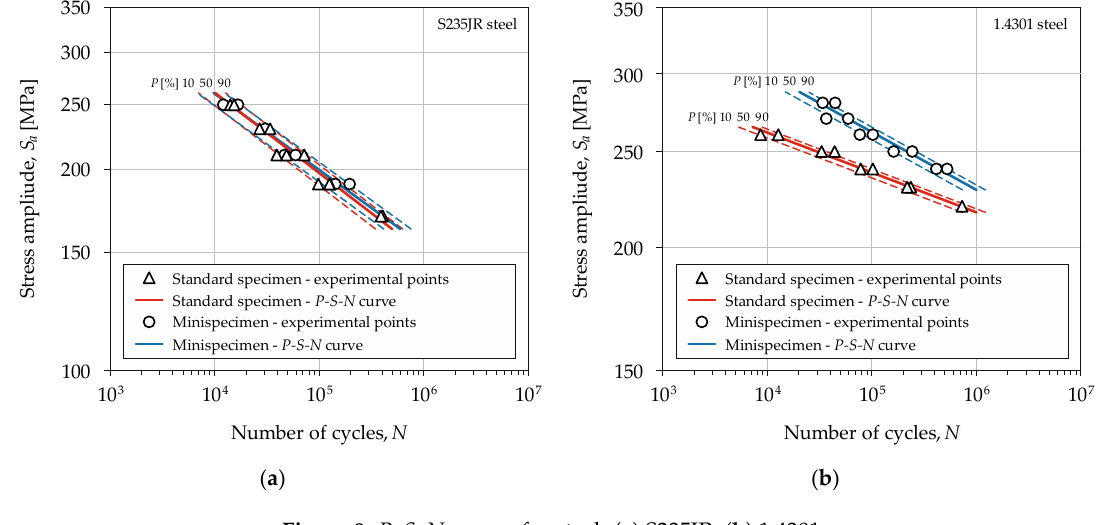
Figure 8. P–S–N curves for steel: ( a ) S235JR; ( b ) 1.4301.